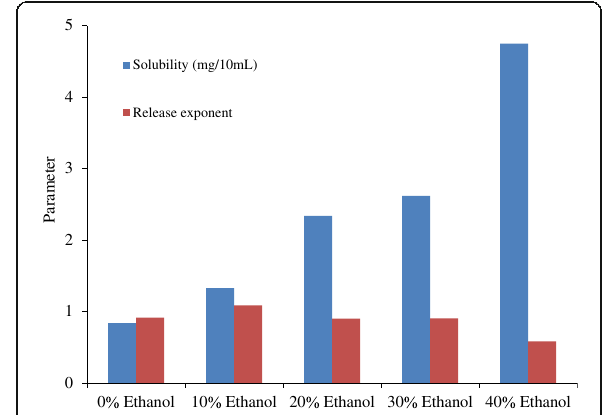
Fig. 22 Effect of hydroalcoholic media on wet weight of methocel compacts (data from reference (Levina et al. 2007))